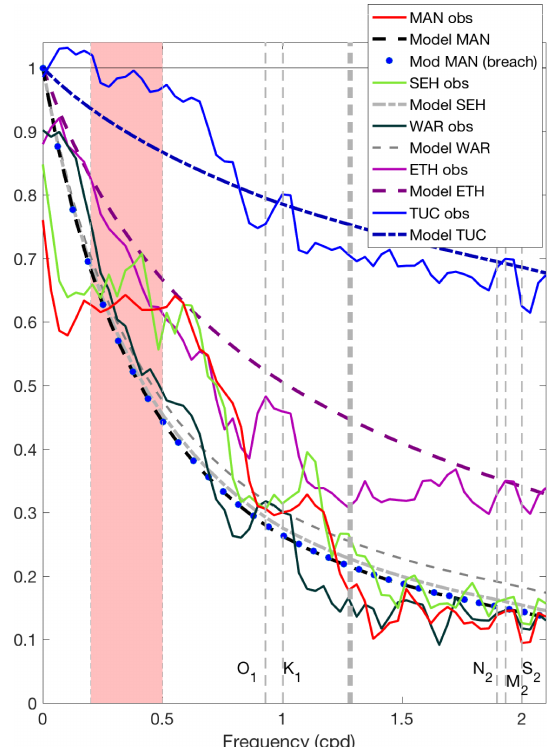
Figure 6. Observed transfer for the longest available record (solid lines) and best analytical model fit for each of the sub-embayments (dashed lines). The vertical shaded area indicates the frequencies corresponding to the storm band